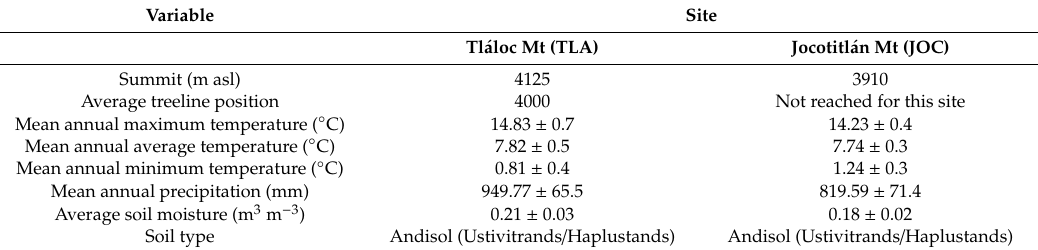
Figure 1. ( a ) Localization of the study area (Tláloc-TLA and Jocotitlán-JOC); ( b ) Climograph representing monthly temperature (lines) and precipitation (bars) values according to climatic data extracted using ClimateNA [44] ; and ( c ) General view of Mexican high-elevation forest at TLA. Table 1. Climatic and topographic characteristics for the study sites.